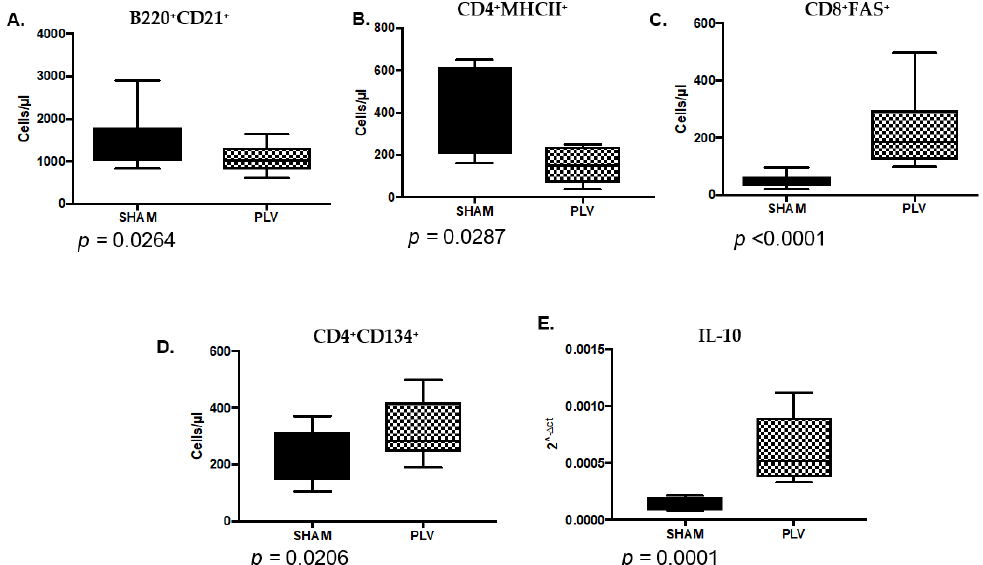
Figure 8. Significantly different blood cells and cytokines are seen between Puma lentivirus (PLV)-infected (PLV) and control cats (SHAM) four weeks after PLV inoculation (at week 0 FIV PI). B220 + CD21 + cells ( A ) and CD4 + MHC II + cells ( B ) were decreased in the PLV cats compared to the SHAM cats. CD8 + FAS + cells ( C ) and CD4 + CD134 + cells ( D ) were increased in the PLV cats when compared to SHAM cats. PBMC IL-10 mRNA expression ( E ) was statistically increased in PLV compared to SHAM